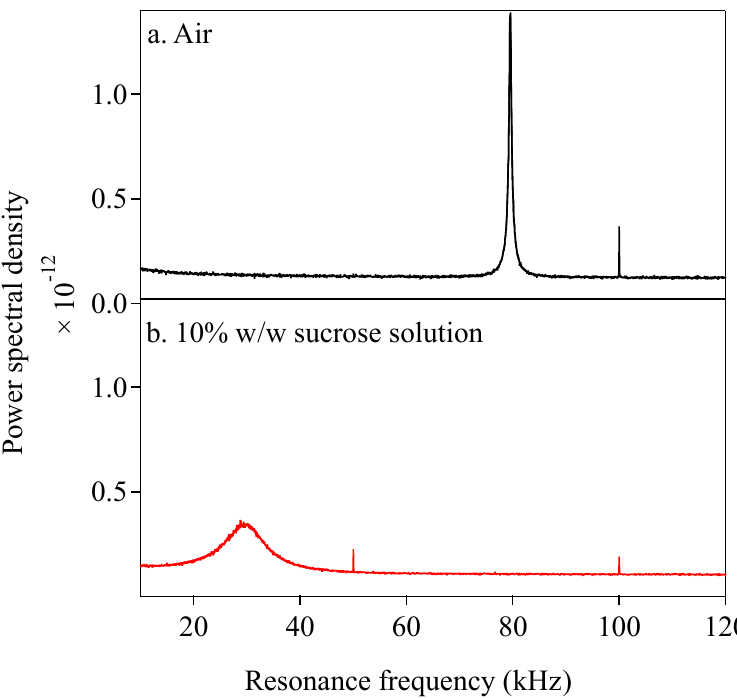
Figure 2. Power spectra density function of AFM cantilever oscillation. ( a ) in air at 25 °C; ( b ) in 10% w / w sucrose at 25 °C. (Cantilever AC240TSA-R3).